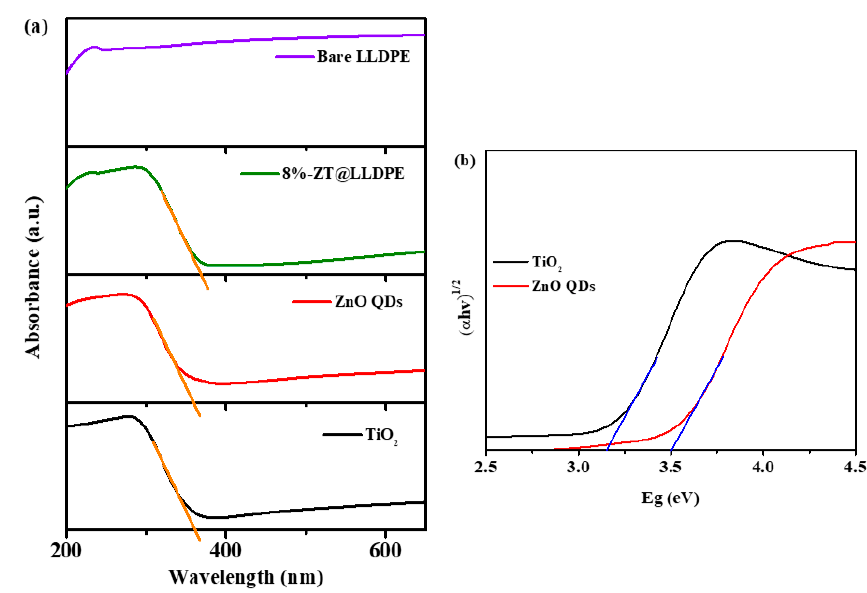
Figure 6. ( a ) Diffuse reflectance UV–Vis spectra of ZT, TiO 2 , ZnO QDs, bare LLDPE, and 8%- ZT@LLDPE; and ( b ) the Tauc plot of ZnO QDs and TiO 2 . ZT@LLDPE; and ( b ) the Tauc plot of ZnO QDs and TiO